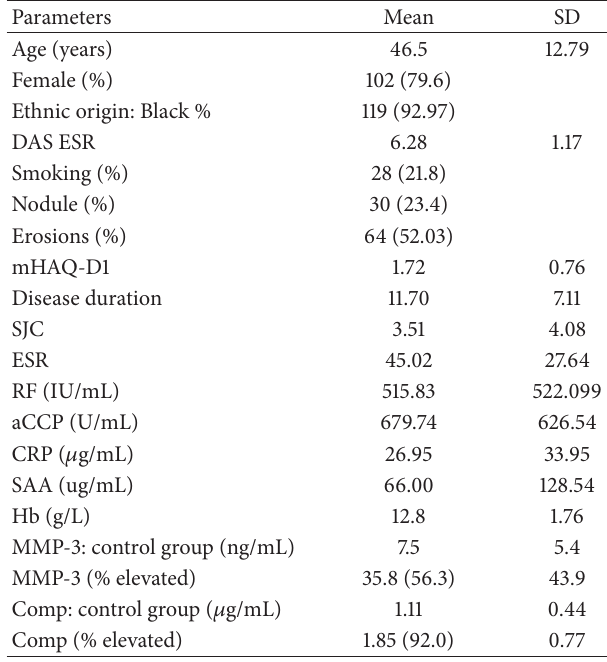
Table 1: Demographic, clinical, and laboratory data for the group of RA patients ( 𝑛 = 128 ).